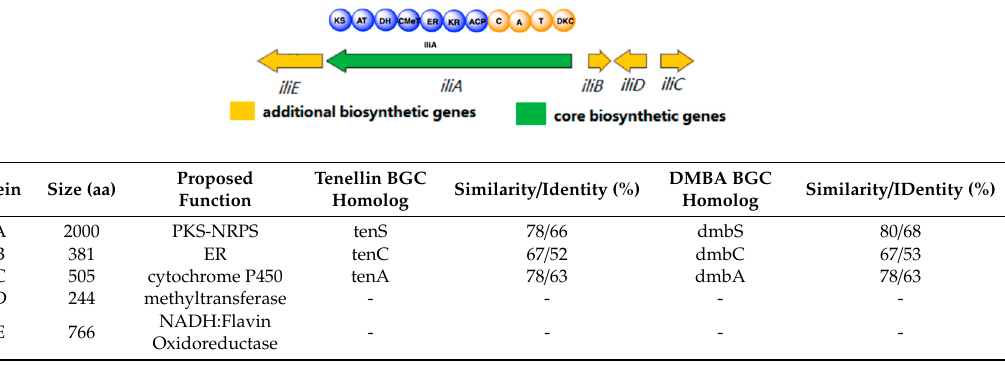
Figure 2. Putative biosynthetic gene cluster of ilicicolin